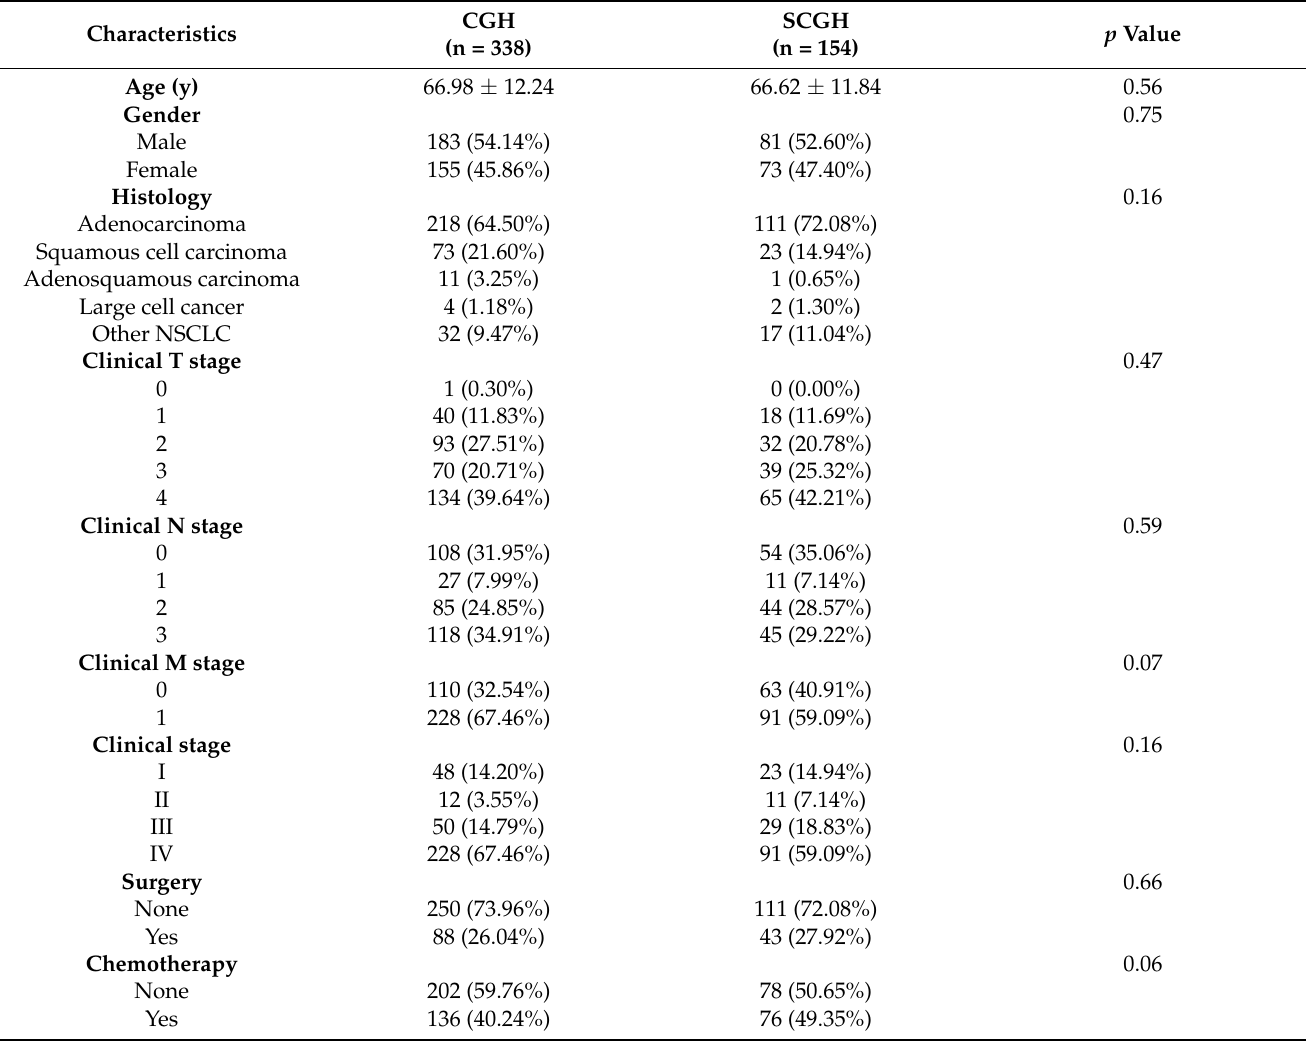
Table 1. Characteristics of non-small-cell lung cancer cases from CGH and